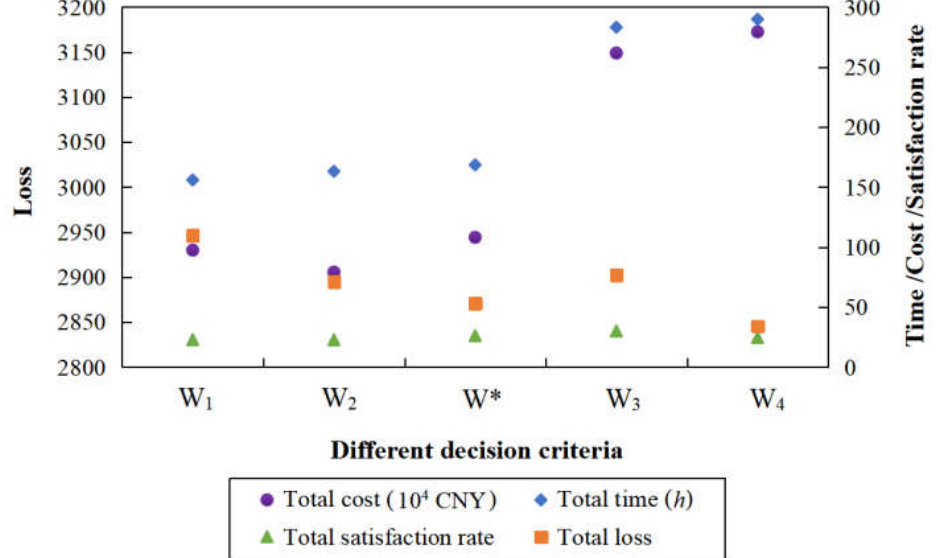
Figure 1. Total time, total cost, total satisfaction rate and total loss of emergency material distribution under different decision criteria.